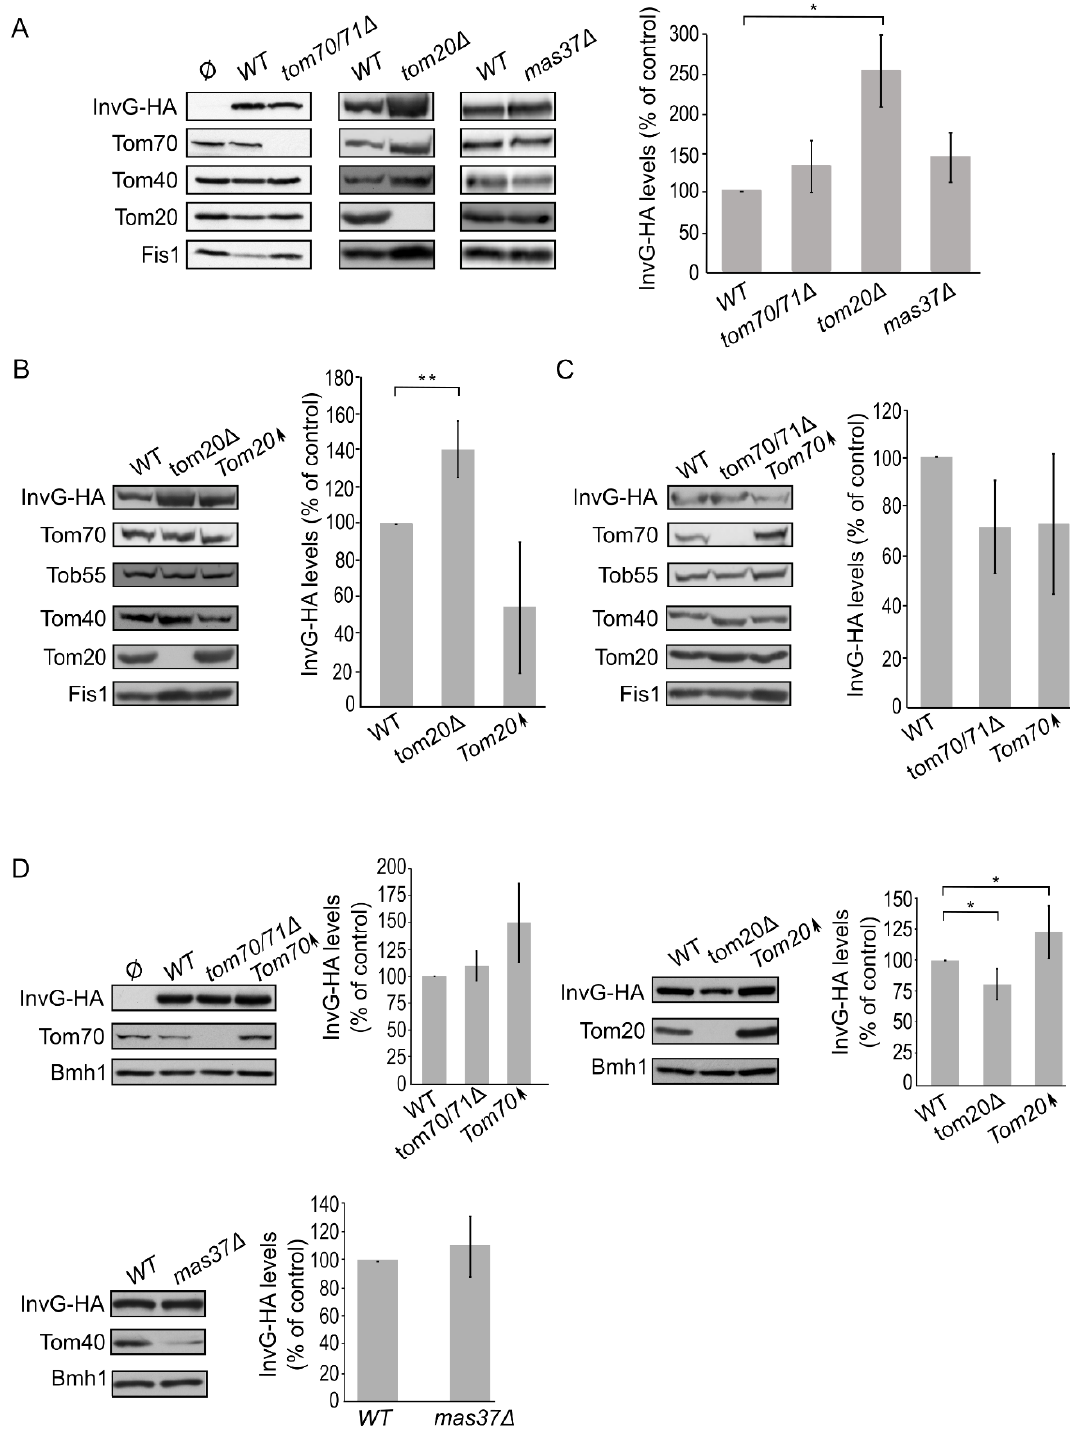
Figure 6. Improved assembly of InvG in mitochondria lacking Tom20. (A) Mitochondria were isolated from the indicated strains transformed with either an empty vector (Ø) or a plasmid encoding InvG-HA. Further treatment and analysis were done as described in the legend of Fig. 4A. (B) Crude mitochondria were obtained from wild type (WT), tom20 Δ or a strain overexpressing TOM20 (Tom20↑) harbouring a plasmid encoding InvG-HA. Further treatment and analysis were as described in the legend of Fig. 4B. (C) Crude mitochondria were obtained from WT, tom70/71 Δ or a strain overexpressing TOM70 (Tom70↑) harbouring a plasmid encoding InvG -HA. Further treatment and analysis were done as described in the legend of Fig. 4B. (D) Whole cell lysate was obtained from the indicated cells and was analysed by SDS-PAGE followed by immunodecoration with antibodies against the indicated proteins. The steady state levels of InvG-HA in at least three experiments for each strain were quantified. The signal of Bmh1 was taken as a loading control. Levels of InvG-HA in the corresponding wild type cells were set to 100%. The bar diagram shows the mean values± s.d. of at least three indepen dent experiments. (*, P < 0.05; two tailed Student's OPEN ACCESS | www.microbialcell.com 22